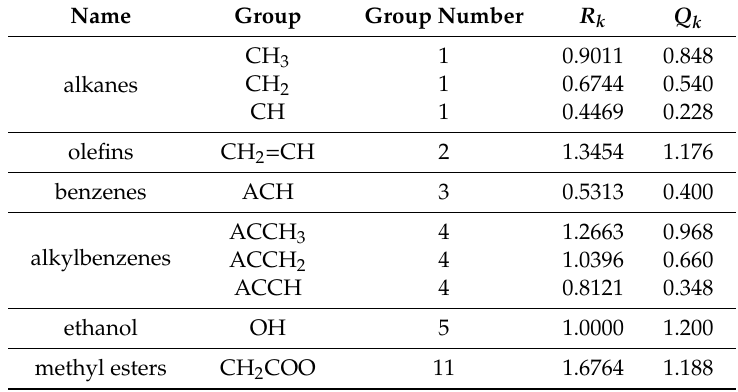
Table A1. Van der Waals volumes ( R k ) and surface areas ( Q k ) for various molecules and